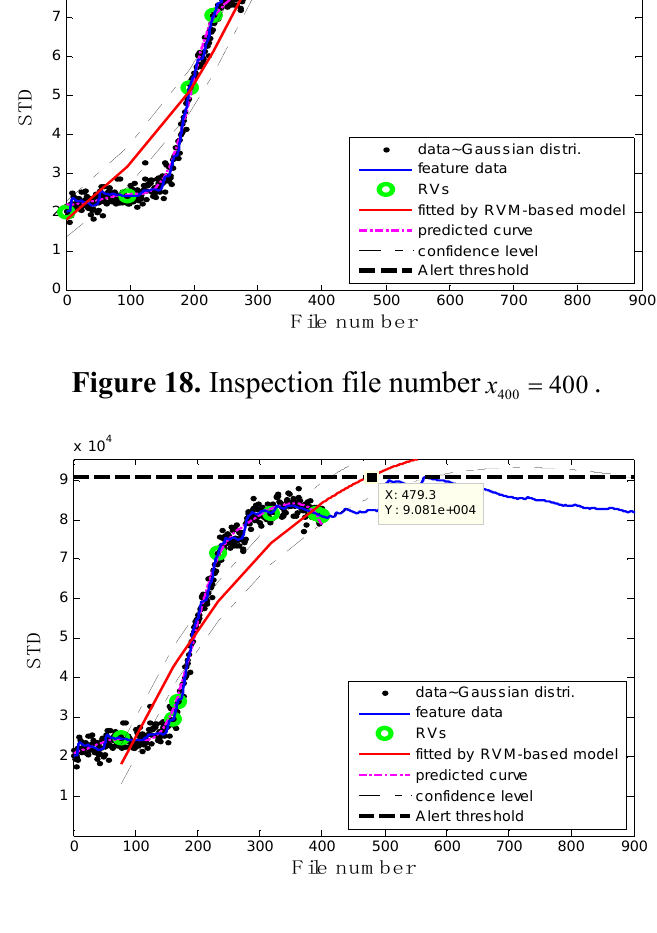
Figure 17. Inspection file number